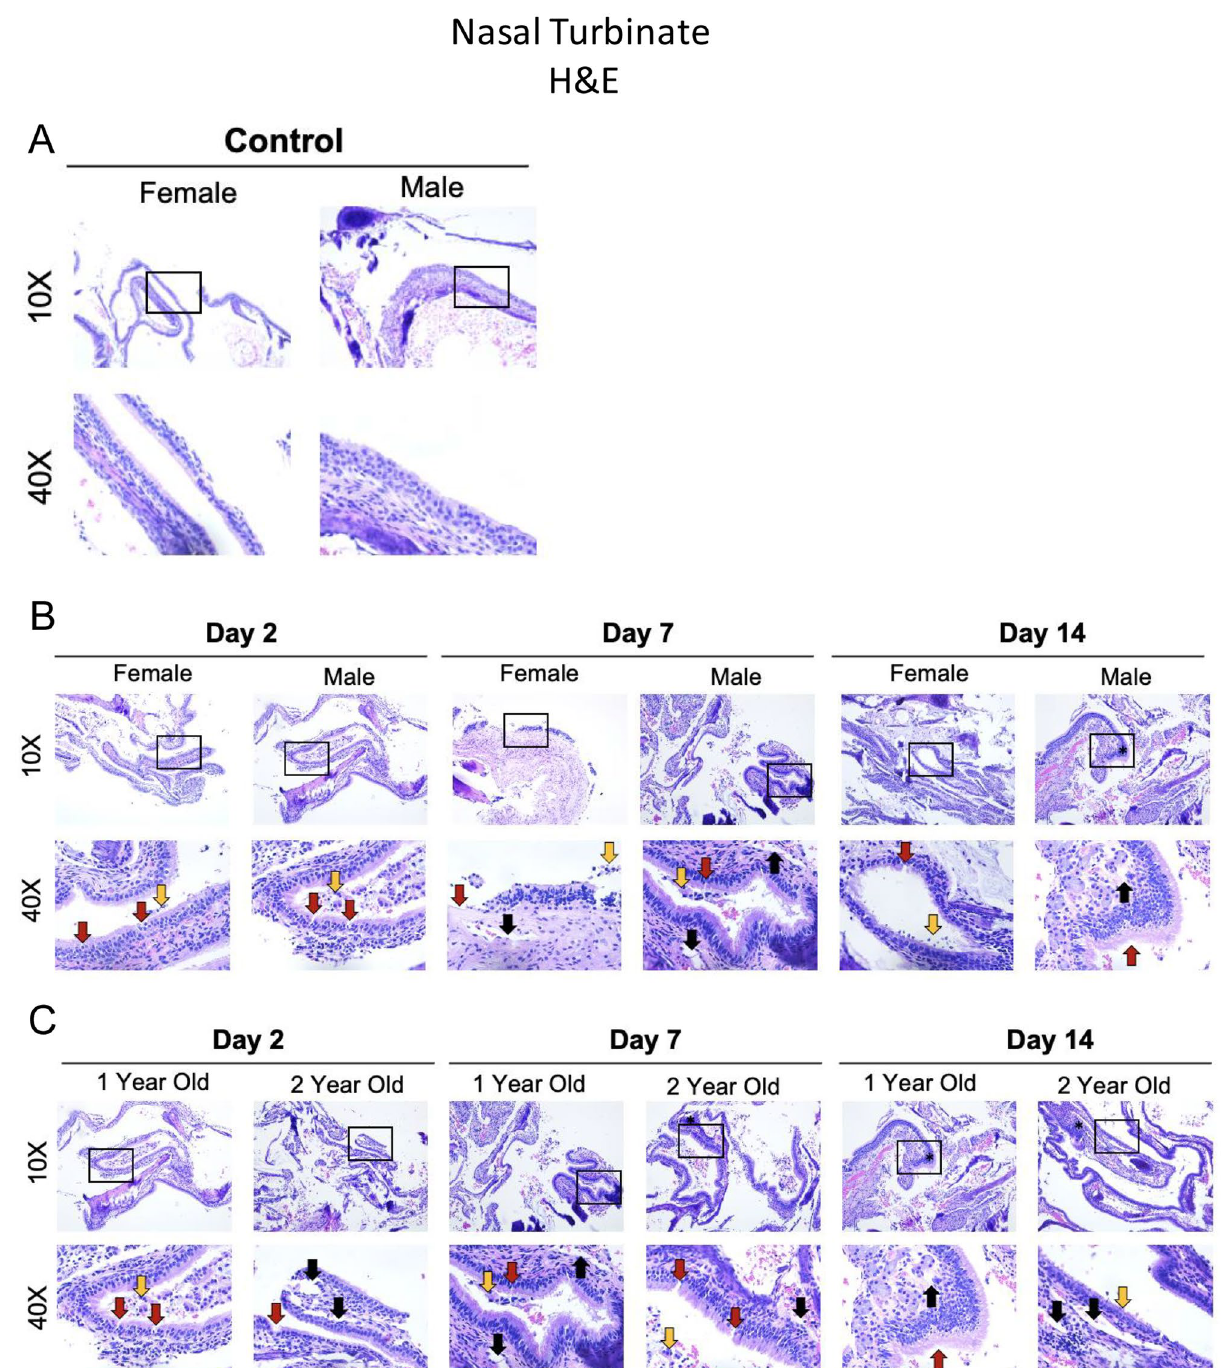
Figure 5. 2-year-old male ferrets inoculated with SARS-CoV-2 have increased damage in the nasal turbinates compared to 1-year-old ferrets. ( A ) Nasal turbinates were examined by H&E collected from uninfected control ferrets. ( B ) Histopathology of H&E-stained nasal turbinates were also analyzed in infected female (1-year-old) versus male (1-year-old) ferrets and ( C ) 1-year-old versus 2-year-old ferrets. The collected nasal turbinates were formalin-fixed and paraffin block embedded prior to slide mounting and staining by H&E. Stained tissues were visualized and images captured via the Leica DMI100 Brightfield microscope and camera. Images were captured at 10× and 40×. Images shown are representative of three animals per group, per timepoint. Black arrows indicate cavity formation; red arrows denote epithelial erosion; and orange arrows point to epithelial cell sloughing. Lines refer to loss of ciliated